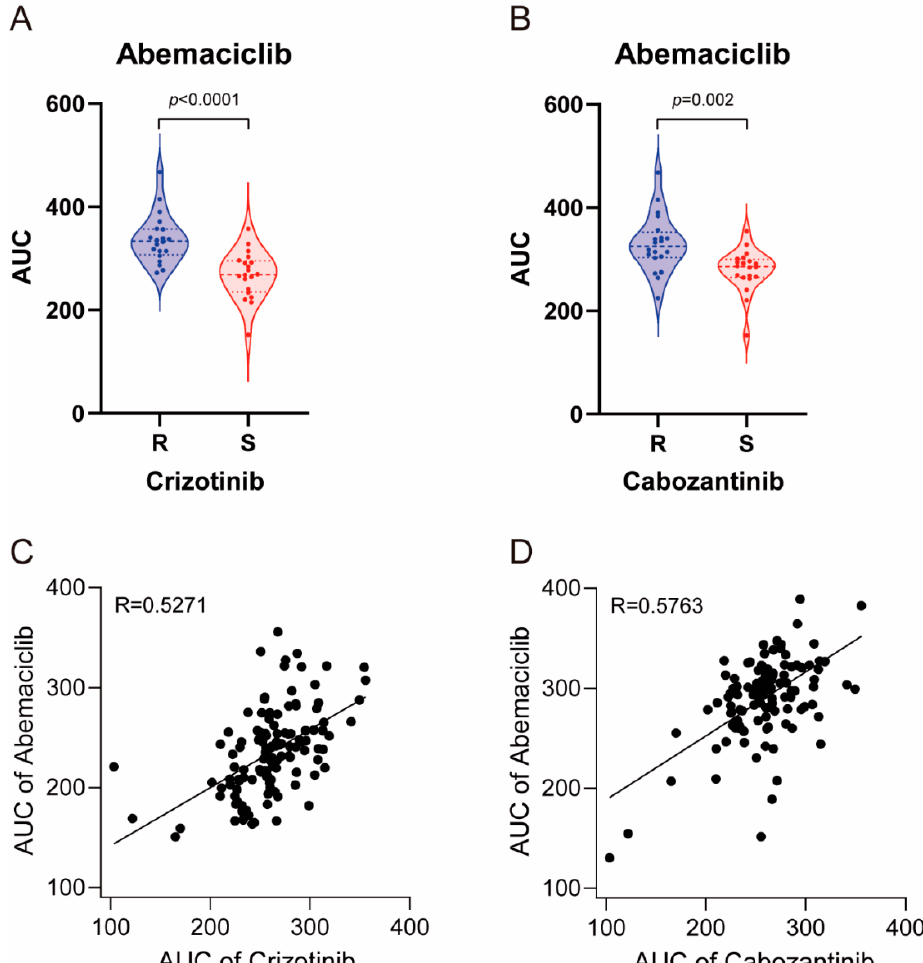
Figure 5. Large-scale sensitivity screening of cancer cell lines and glioblastoma patient-derived cells in abemaciclib, crizotinib and cabozantinib. ( A ) Violin plots showing AUC values of abemaciclib in 20 sensitive and 20 resistant cancer cell lines to crizotinib; p value is indicated in the graph. ( B ) Violin plots showing AUC values of abemaciclib in 20 sensitive and 20 resistant cancer cell lines to cabozantinib; p value is indicated in the graph. ( C ) Scatter plots showing AUC values of abemaciclib and crizotinib in 125 cases of patient-derived glioblastoma. Pearson’s coefficient (r) is indicated in the graph. ( D ) Scatter plots showing AUC values of abemaciclib and cabozantinib in 125 cases of patient-derived glioblastoma. Pearson’s coefficient (r) is indicated in the graph.